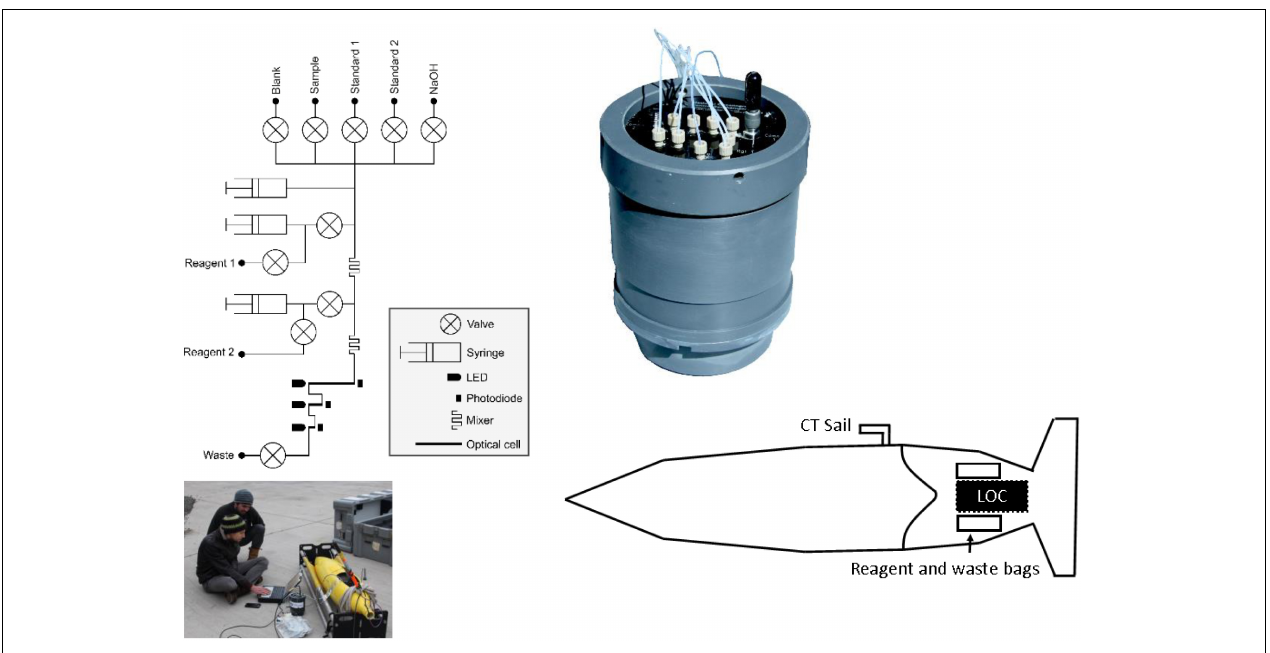
FIGURE 1 | Fluidic diagram of the phosphate Lab-on-Chip analyser, picture of integration into glider Ogive faring, schematic showing location of analyser and reagent bags with the Seaglider (not to scale) and a close-up picture of the Lab-on-Chip analyser in pressure compensating housing.